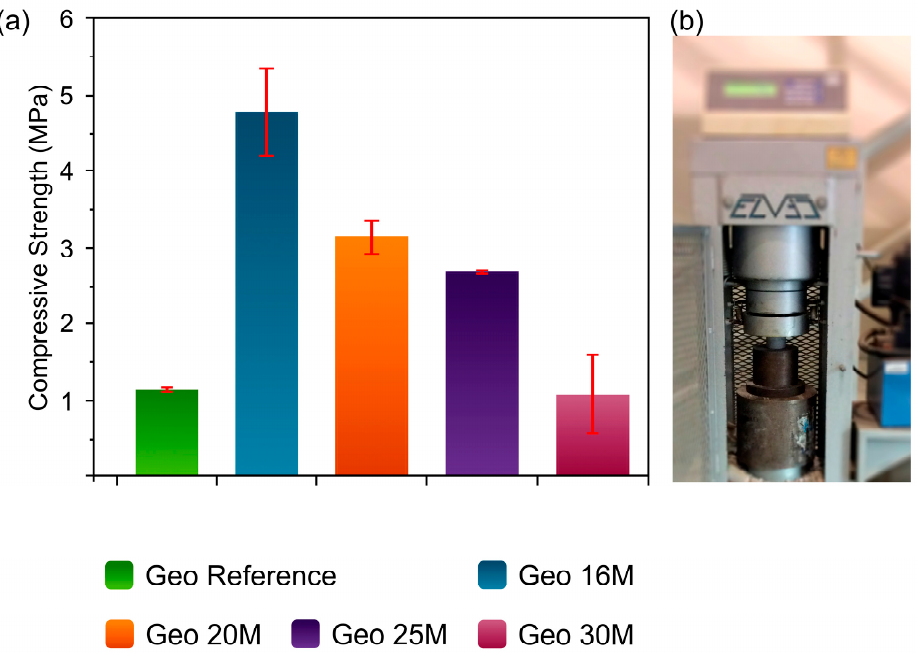
Figure 5. ( a ) Compressive strength values of the Geo Reference, Geo 16M, Geo 20M, Geo 25M, and Geo 30M samples. ( b ) Evaluation of the compressive strength of a sample.